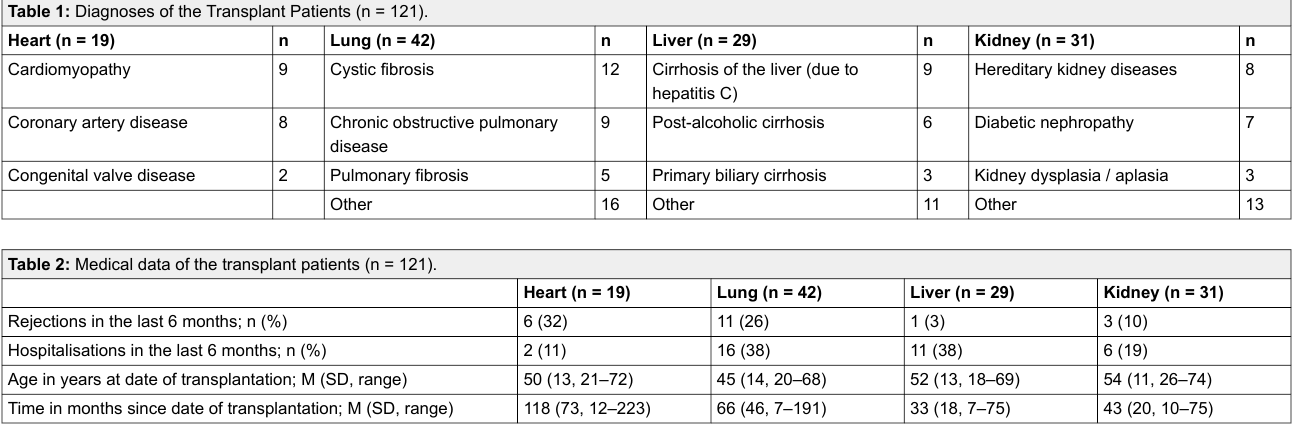
Table 1: Diagnoses of the Transplant Patients (n = 121). Heart (n = 19)